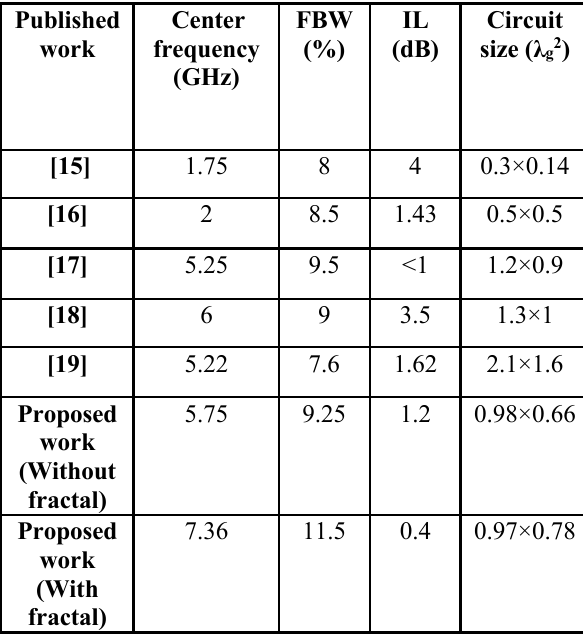
Table.III. Comparison with published bandpass